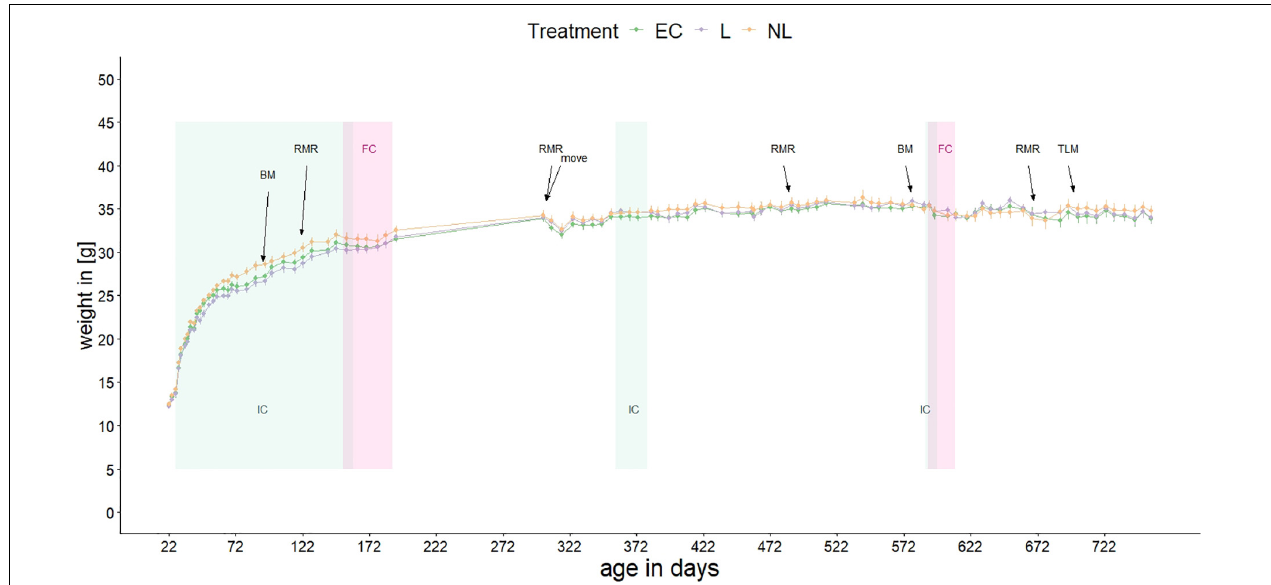
FIGURE 2 | Body mass of mice over their lifetime. Shown are the mean body masses of the three treatment groups. At 305 days of age, the mice moved to another animal facility. Repeated experiments were conducted: IC, IntelliCage; FC, female choice test; BM, Barnes maze test; RMR, resting metabolic rate; TLM, telomere length measurement. When not in the ICs, the mice were kept in standard home-cages within their social